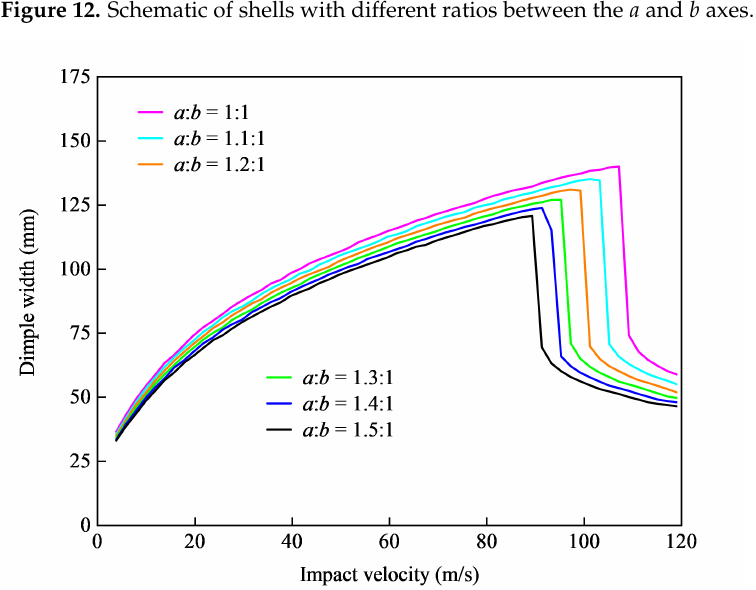
Figure 13. Influence of the ratio between the a and b axes on the dimple depth, generated by projectiles impacting at different